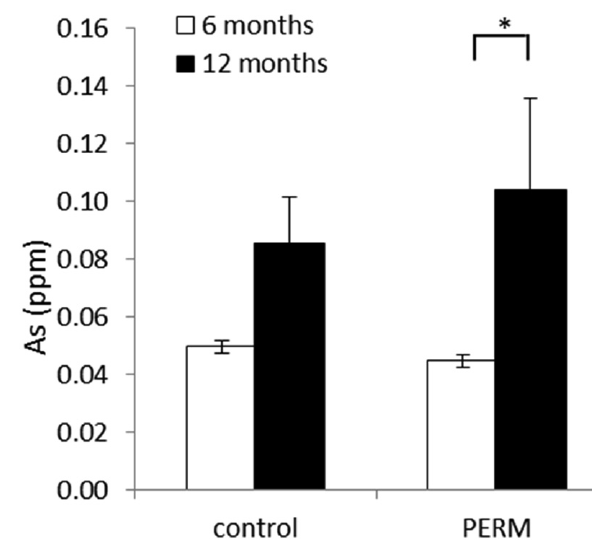
Figure 2. Analysis of As in hair from early life PERM-treated rats and control ones at six and 12 months of age. Data are expressed as the mean values ± SEM. * p < 0.05.